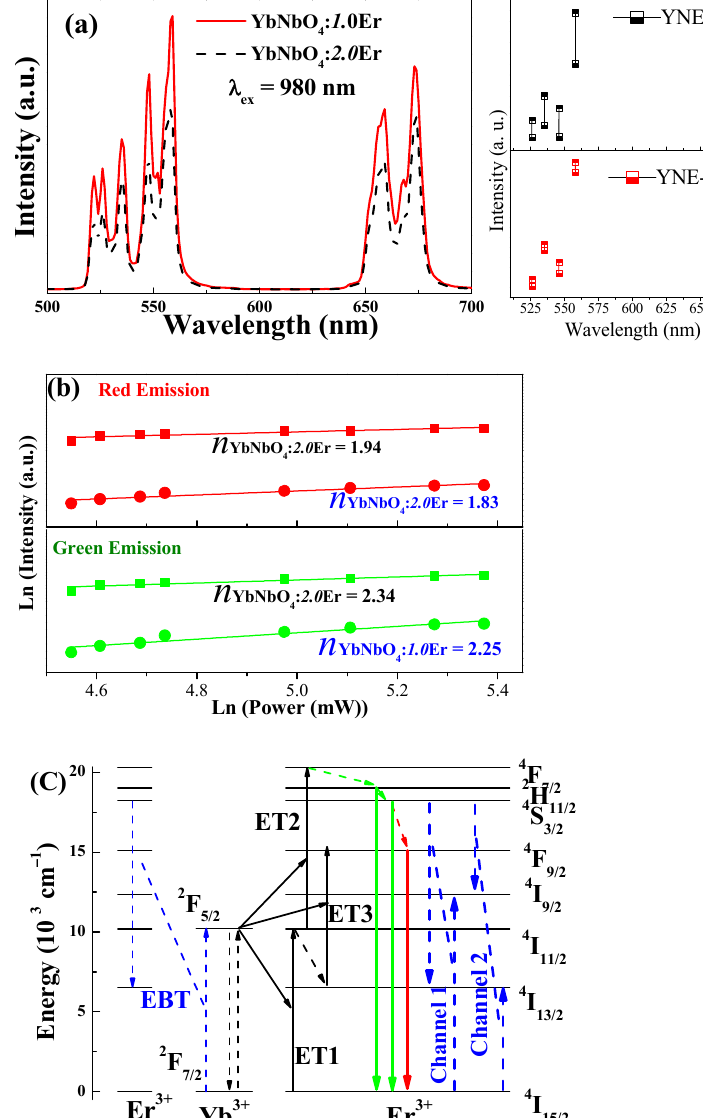
Figure 3. ( a ) Upconversion (UC) emission spectra; ( b ) pump power dependency; ( c ) UC mechanism of YbNbO 4 :Er 3+ under 980 nm excitation. Error bars represent the standard deviations from three repeated